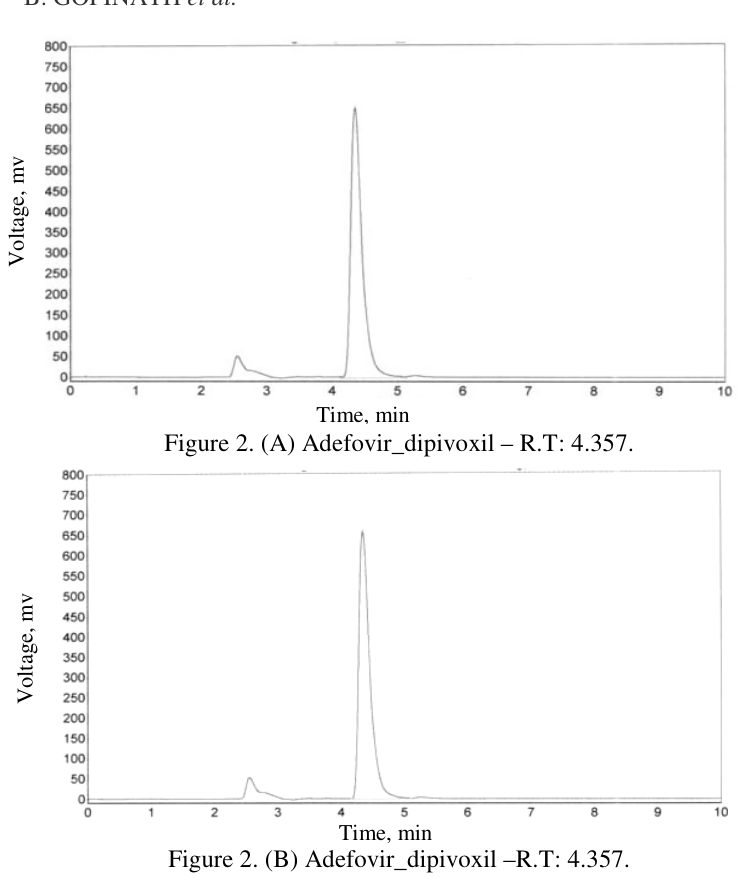
Figure 2. (A) Adefovir_dipivoxil – R.T: 4.357.